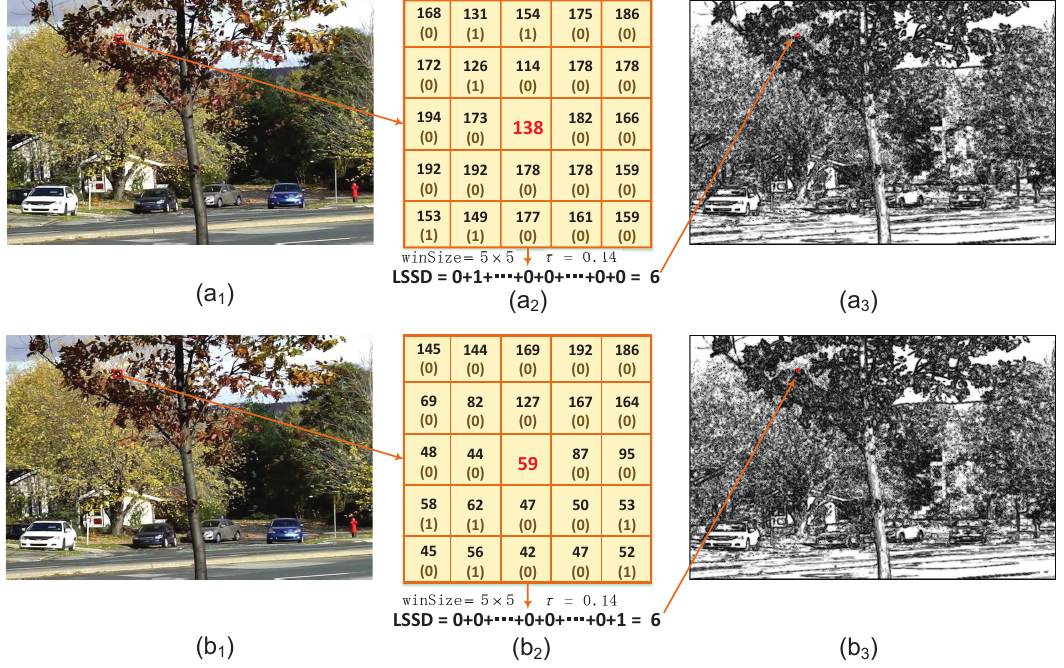
Figure 4. An LSSD encoding example under dynamic backgrounds. First column: input images. Second column: the intensity values of the small red box in the input images. Third column: the corresponding LSSD feature